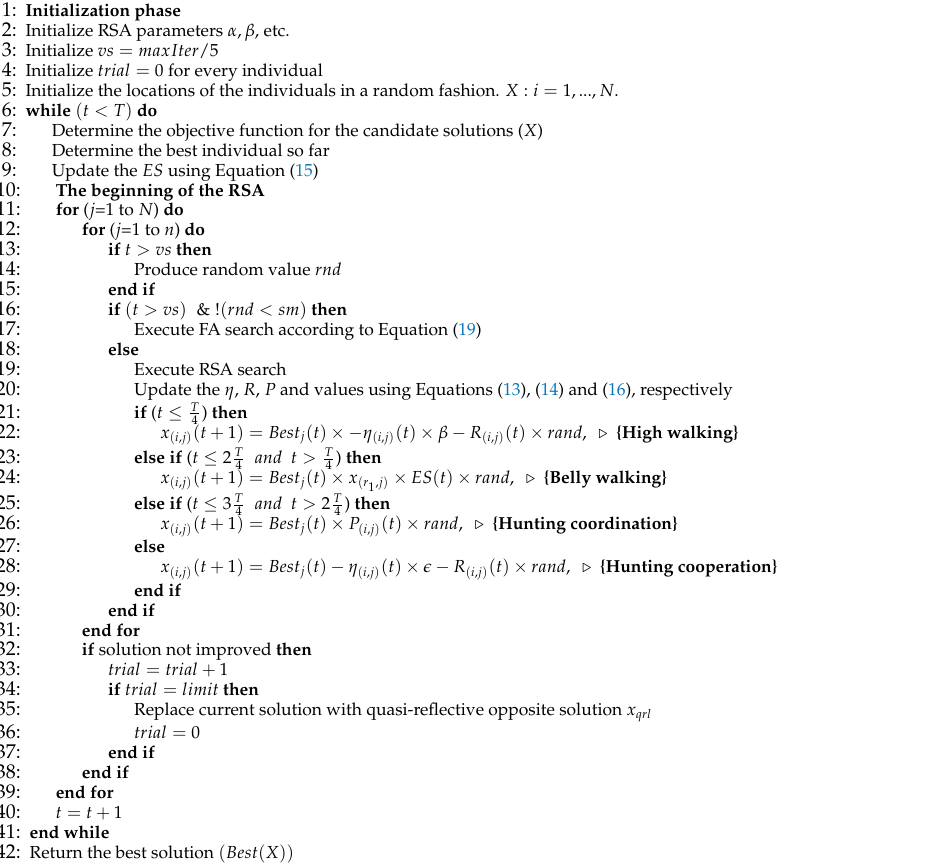
Algorithm 1 Pseudo-code of introduced hybrid reptile search algorithm